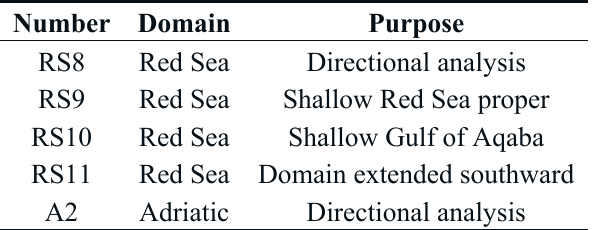
Figure 8. Directional plot for Aqaba, Nuweiba, and Tiran. Table 3. Simulation experiments